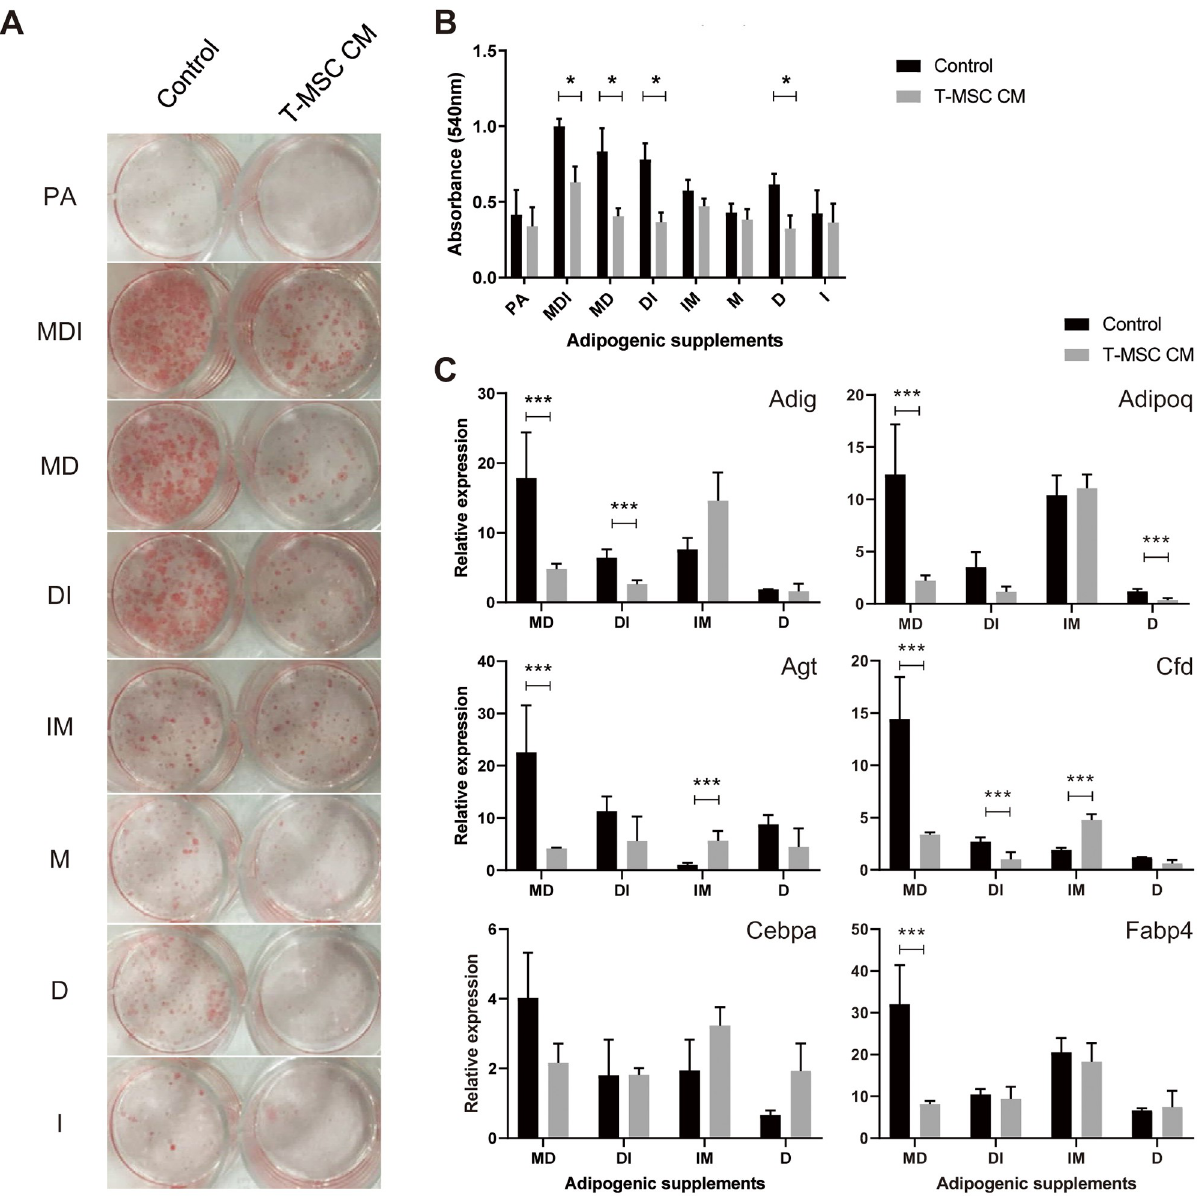
Fig 2. T-MSC CM selectively inhibits GC signaling. Adipocyte differentiation was induced using adipogenic factors individually or in combinations with or without T-MSC CM. (A) Photomicrograph of adipocyte differentiation taken after Oil Red O staining on differentiation day 10. (B) Quantification of Oil Red O staining measured at absorbance 540 nm. (C) mRNA expression of the adipogenic genes Adig, Adipoq, Agt, Cfd, Cebpa, and Fabp4 on differentiation day 3 was determined using RT-qPCR. Data are presented as mean ± SEM and were analyzed using Student’s t -tests (n = 3, � P < 0.05, ��� P < 0.001). PA, preadipocyte; M, IBMX; D, dexamethasone; I,